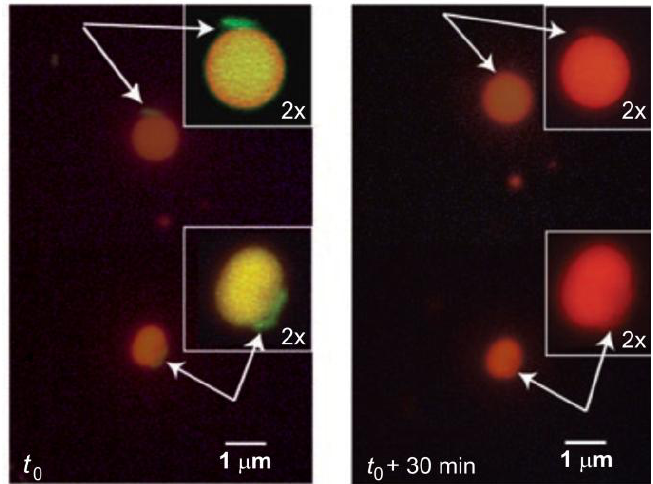
Figure 12. Information transfer at interfaces between PGEMA- b -PDEGMA block copolymer vesicles and E.coli cells. Fluorescence microscopy image (left) of orange-red fluorescing vesicles containing ethidium bromide, and green fluorescing bacteria. The right image shows the same vesicle-cell partners after 30 min, with the bacteria fluorescing in orange-red owing to transfer of the dye. Insets show the objects at higher image contrast and 2× magnification. Reproduced by permission of Wiley